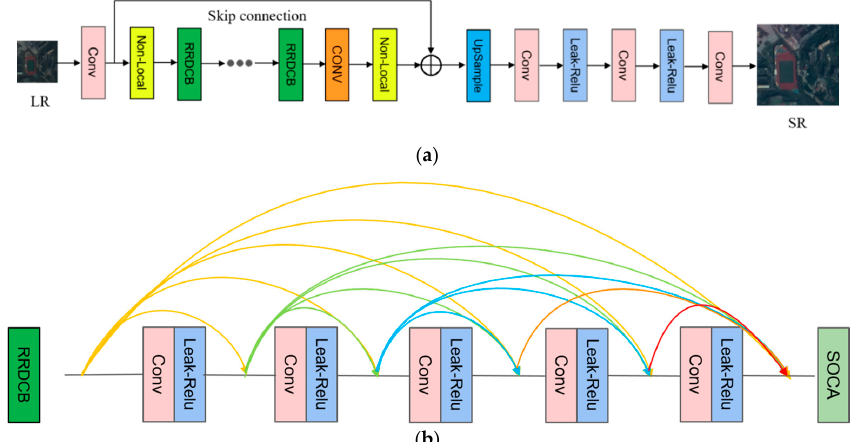
Figure 4. Network structure of generative network: ( a ) The structure of the generator. LR represents low-resolution images, and SR represents the results for network reconstruction. ( b ) The structure of the residual in residual dense second-order channel attention block (RRDCB).